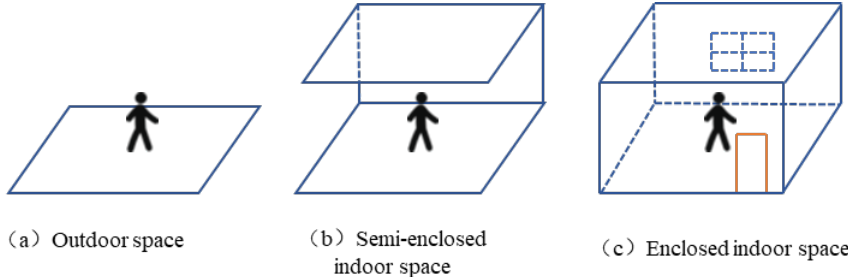
Figure 5. The distinction between indoor and outdoor spaces based on the top surface.